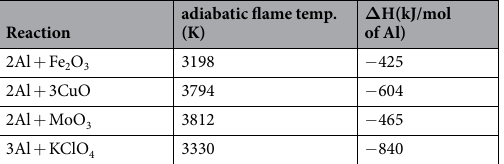
Table 1. Thermodynamics of Al combustion in different